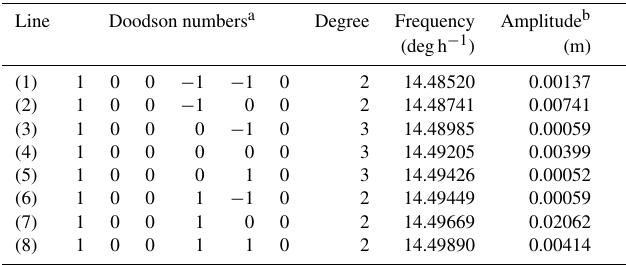
Table 1. Lines in the tidal potential within the M1